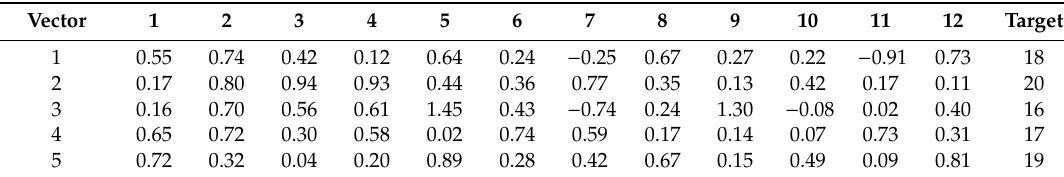
Table 13. Target vectors for the next